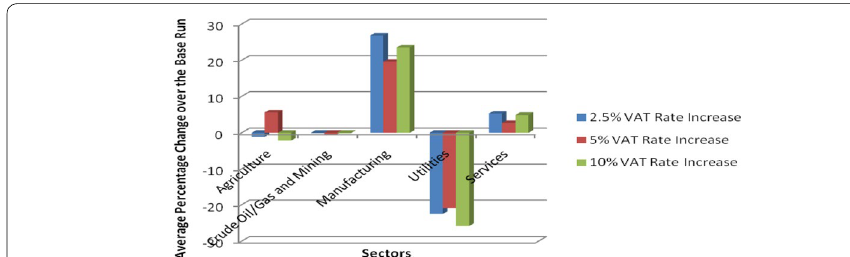
Fig. 28 Percentage change in capital stock over the ten-year period